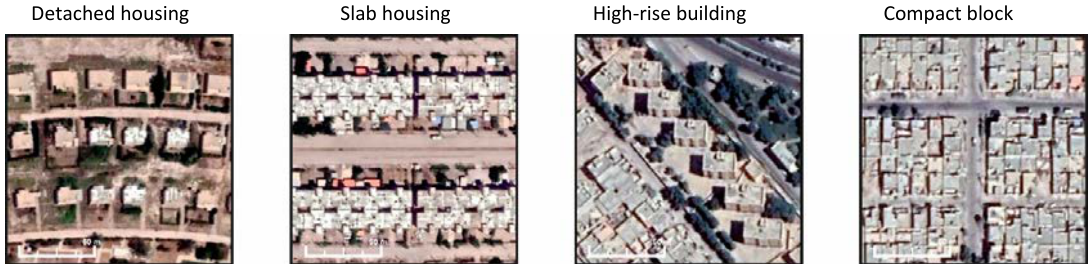
Fig. 3: Sample images of Khorramshahr urban morphotypes from Google Earth Detached housing